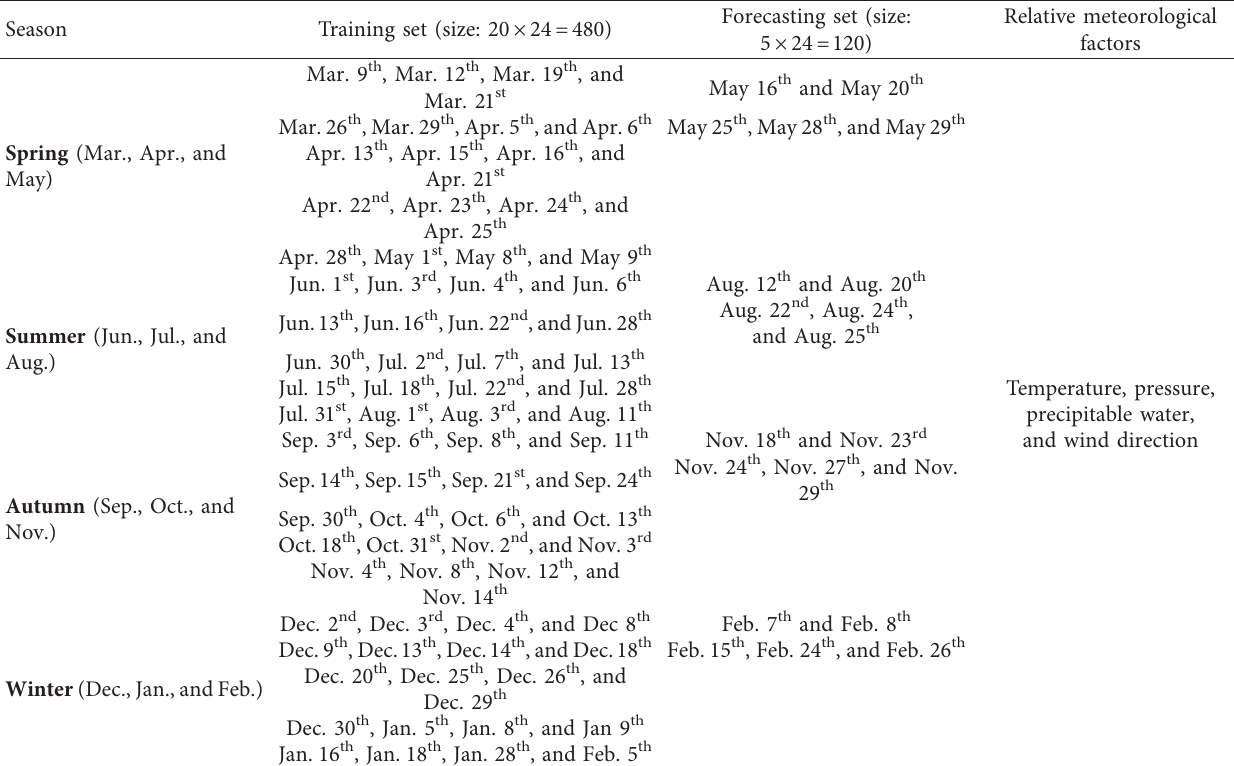
Figure 4: Distribution and location information of the observation sites. Table 1: Training sets and forecasting sets for hourly wind speed data at six